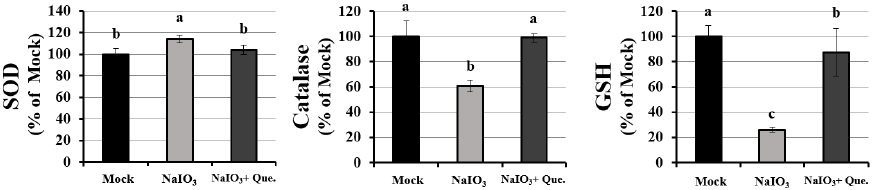
Figure 2. Quercetin improved the abnormal pupillary response in NaIO 3 -treated mice. Pupil sizes were measured 7 days after NaIO 3 treatment in the mock, NaIO 3 , and NaIO 3 + quercetin (Que.)-treated mice. ( A ) Slit-lamp pictures showed the responses of pupil size under dark/light environments. Arrows indicate the increased pupil size in the NaIO 3 -treated groups compared with the mock group (light intensity = 1000 lx). ( B ) Pupil size was measured 7 days after NaIO 3 treatment at light intensities of 10–1000 lx, and quantified by ( C ) the percentage of pupil constriction. Figure 3. Activities of oxidative metabolic enzymes. All enzymes were measured 7 days after NaIO 3 treatment in the mock, NaIO 3 , and NaIO 3 + quercetin groups of mice. SOD, catalase, and glutathione were measured using commercial assay kits. Data are demonstrated as mean ± SD ( n = 8, 8 individual set experiments per set of groups). The letters a, b, and c indicate statistically significant difference ( p <